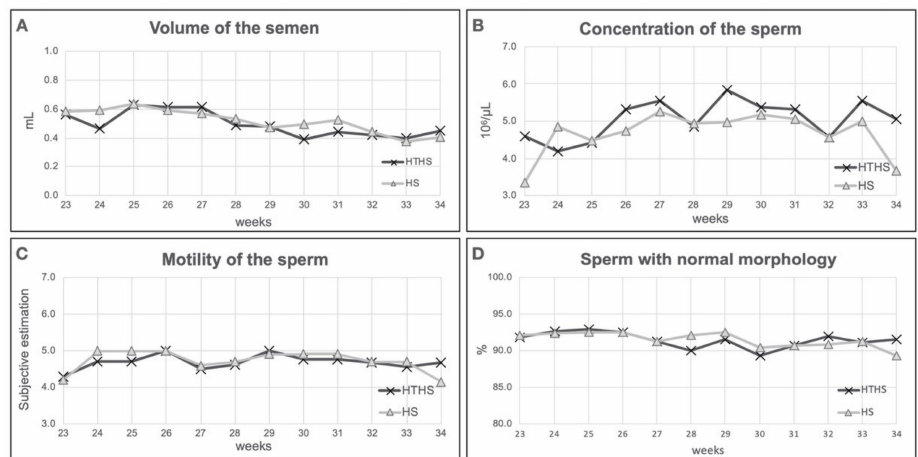
Figure 1. In this figure the results of heat-treated (HTHS) and control (HS) groups under 12 weeks of heat stress on sperm parameters are summarized. Significant difference between the two groups was not found. ( A ): Volume of the semen. ( B ): Concentration of the sperm. ( C ): Motility of the sperm. ( D ): Sperm with normal morphology.